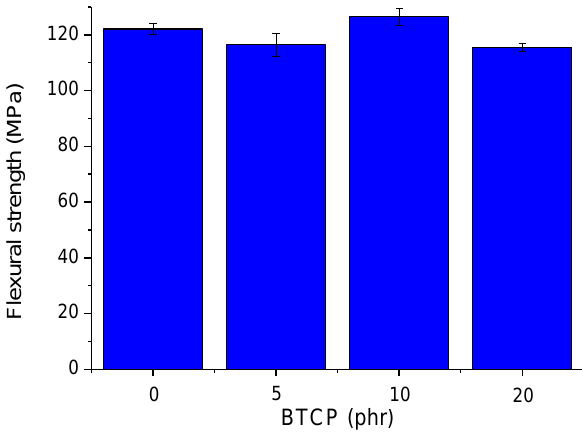
Figure 9. Flexural strength of cured epoxy samples.